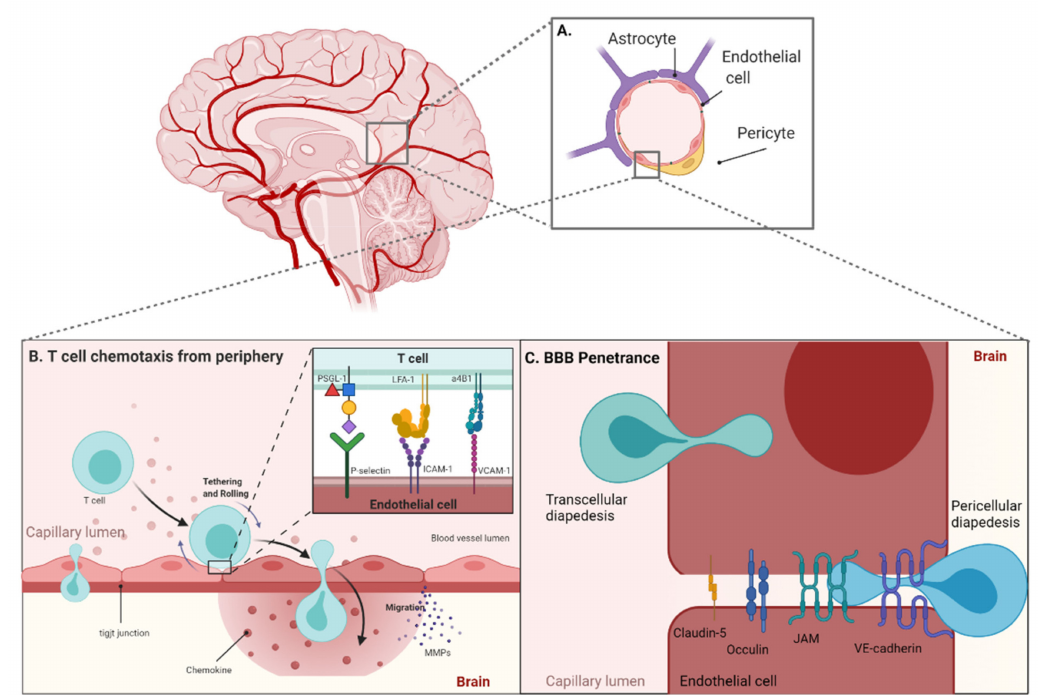
Figure 1. ( A ) The BBB consists of endothelial cells held together by tight junctions surrounded by pericytes and astrocytes. ( B ) T cell chemotaxis across the BBB is facilitated by expression of tethering molecules (P-selectin, ICAM-1, VCAM-1, etc.) on endothelial cell surfaces that bind to integrins on circulating T cells (LFA-1, α 4 β 1, etc.) to slow and allow cells to roll across the membrane surface. ( C ) T cells can cross the endothelial cells either between cells (paracellular) through tight junctions or through individual cells (transcellular) to migrate into the brain. Produced using